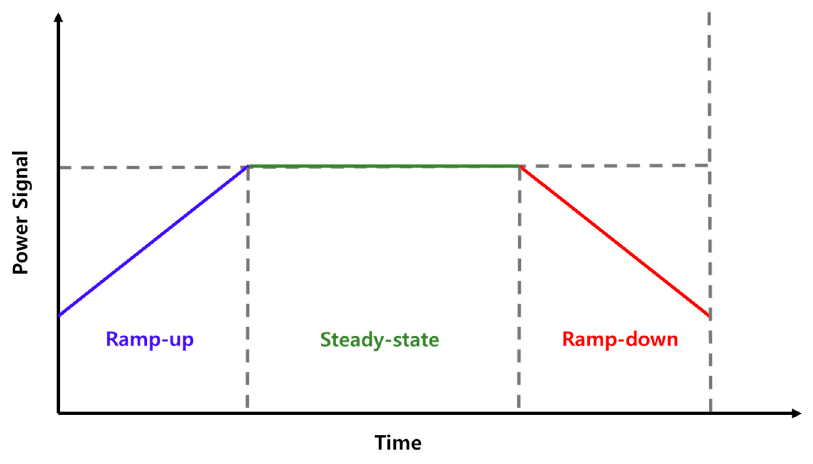
Figure 1. The ramp rate curve with ramp-up (blue), steady-state (green) and ramp down (red).